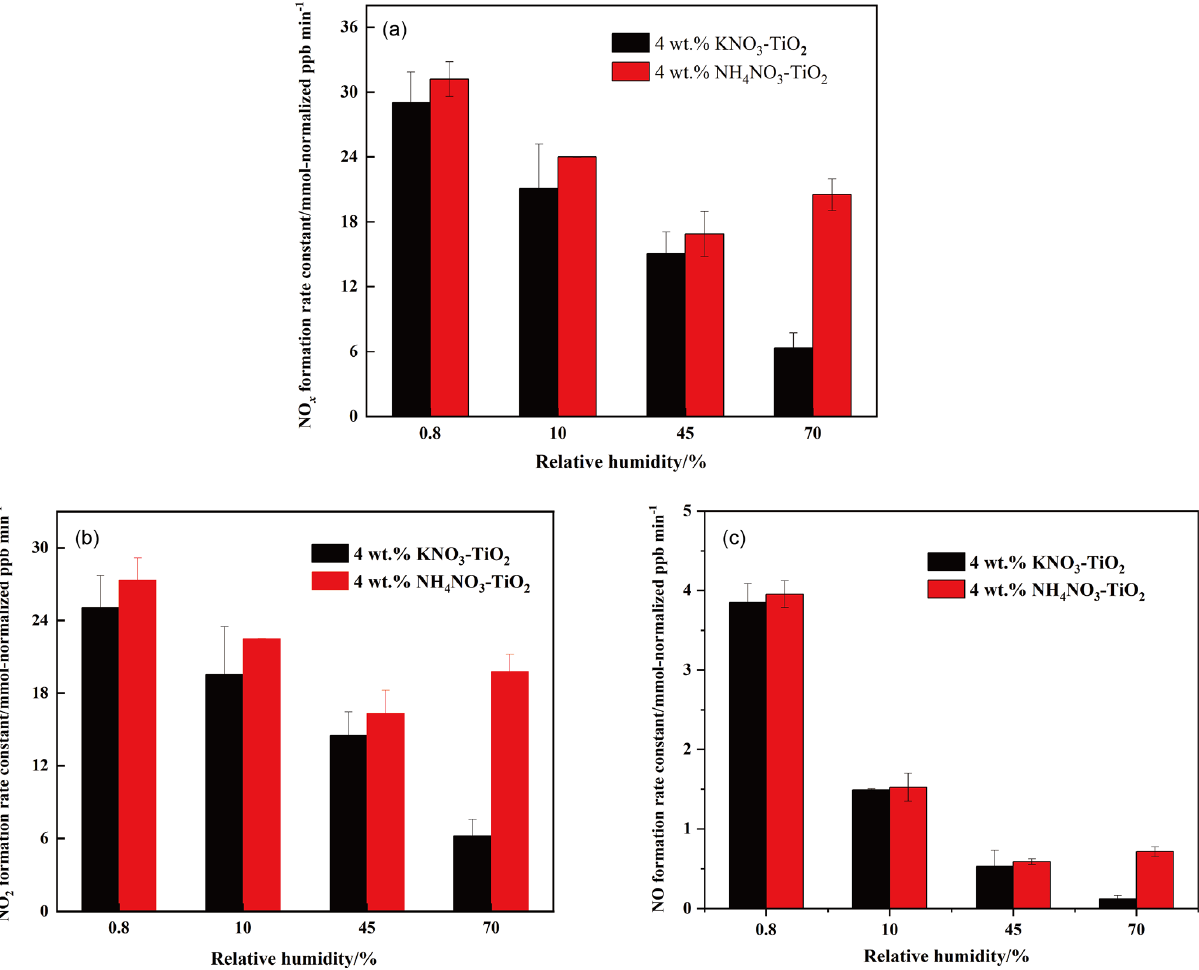
Figure 4. Effect of relative humidity on the release of NO x (a) , NO 2 (b) , NO (c) over 4wt% NH 4 NO 3 –TiO 2 and 4wt% KNO 3 –TiO 2 particles at 293K; 365nm LED lamps were used during the illumination experiment. The initial concentration of HCHO was about